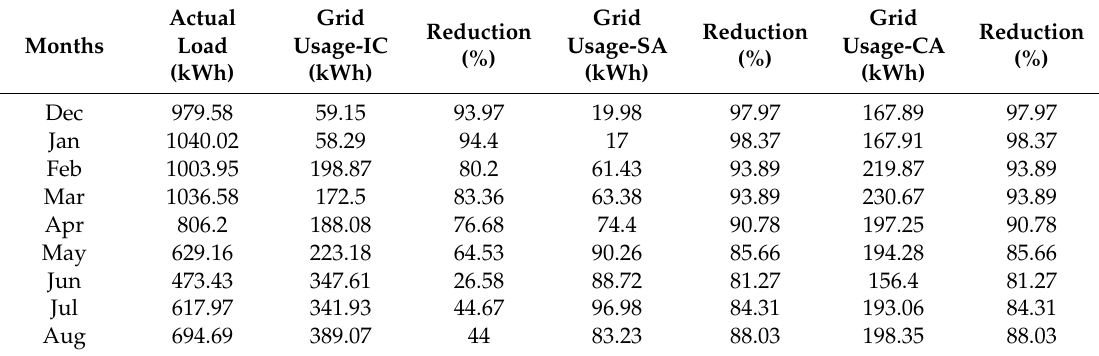
Table A1. Monthly grid usage reduction for CP load using three strategies at Evermore.